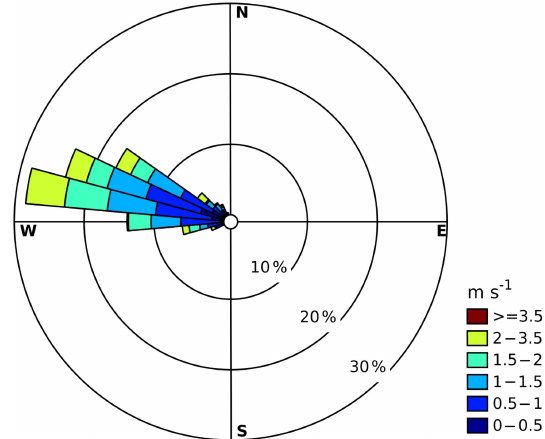
Figure 2. Wind rose at 6m over the 2h after the onset of the downs- lope flow for the 40 selected